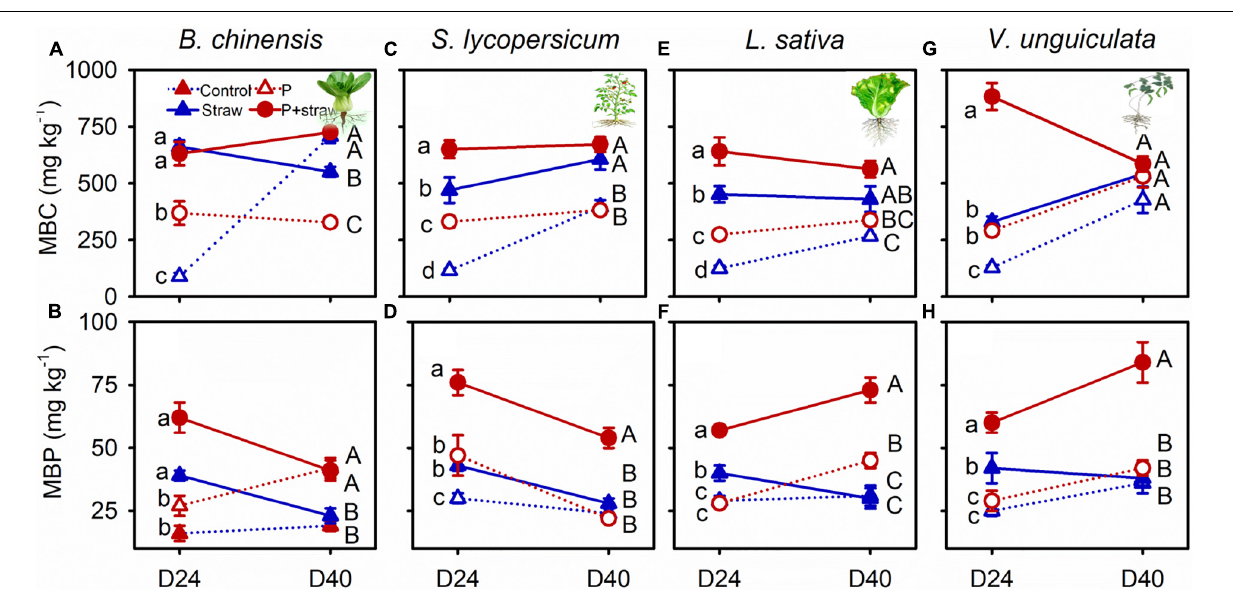
treatments without P or straw, with straw but no fertilizer P, with fertilizer P but no straw, and with fertilizer P and straw at day 24, and the capital letters denote significant differences ( p ≤ 0.05) among the four treatments at day